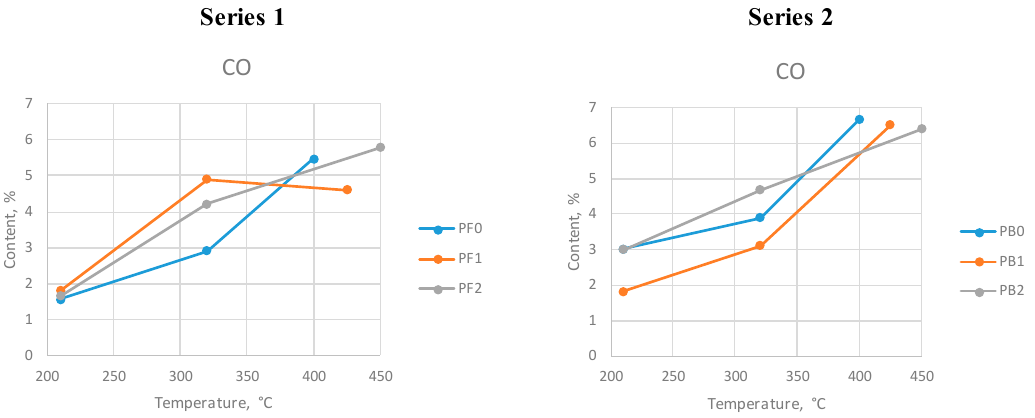
Figure 5. Carbon oxide content at different max. temperatures during series 1 and 2.